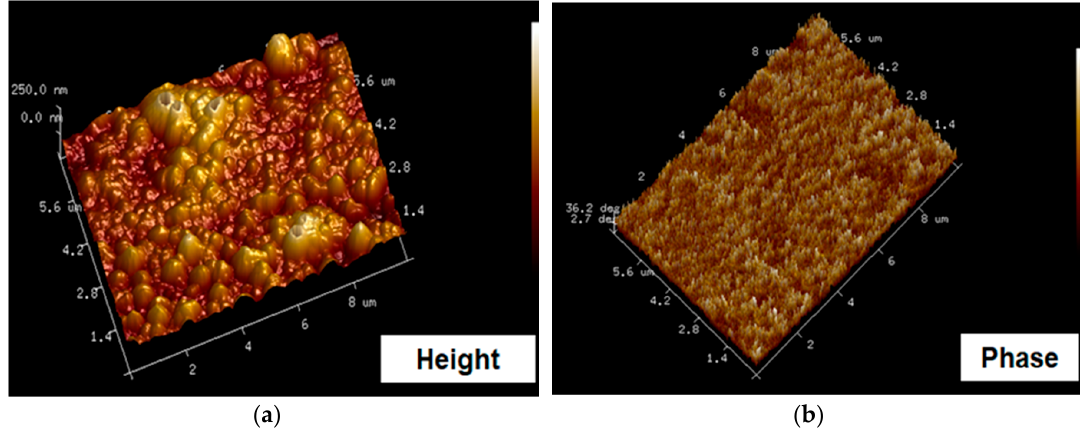
Figure 11. AFM images obtained from the surface of Parylene C-coated Zn stents. ( a ) Surface